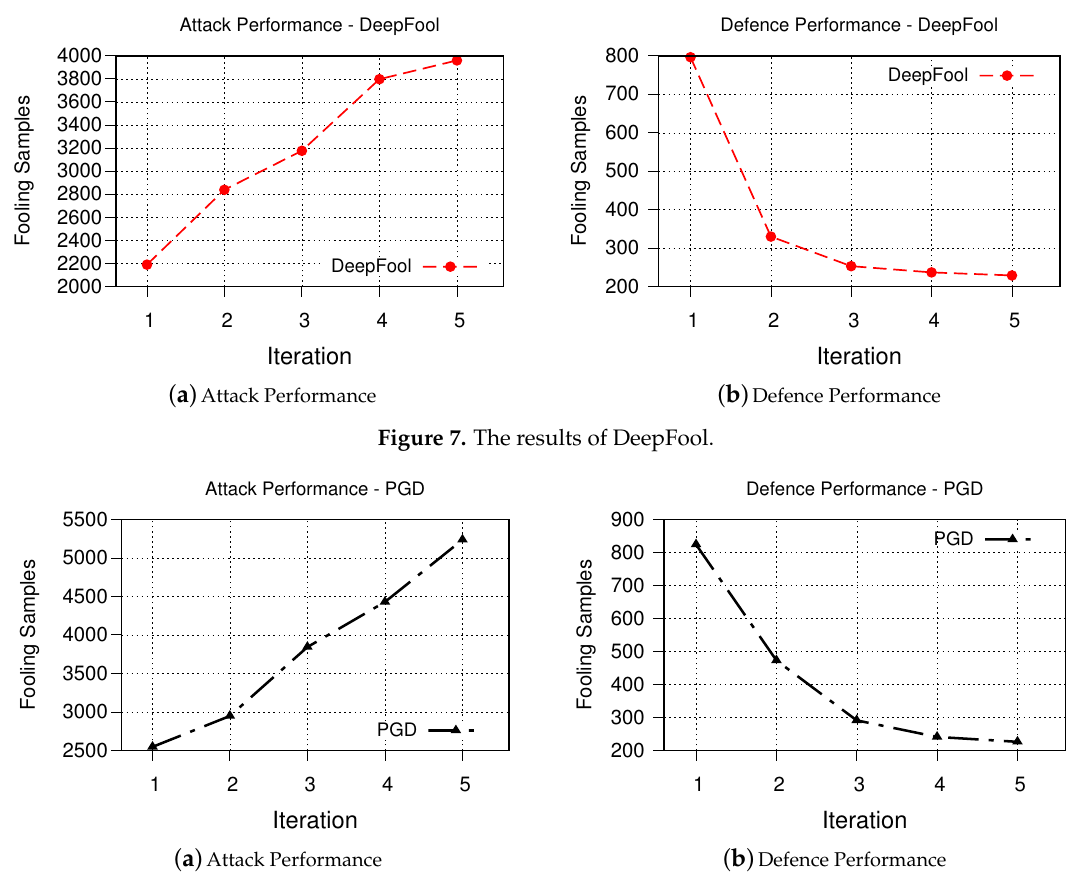
Figure 8. Our simulation results based on PGD attack method. While ( a ) presents attack performance, ( b ) shows the success of our proposed defensive system for five iterations.